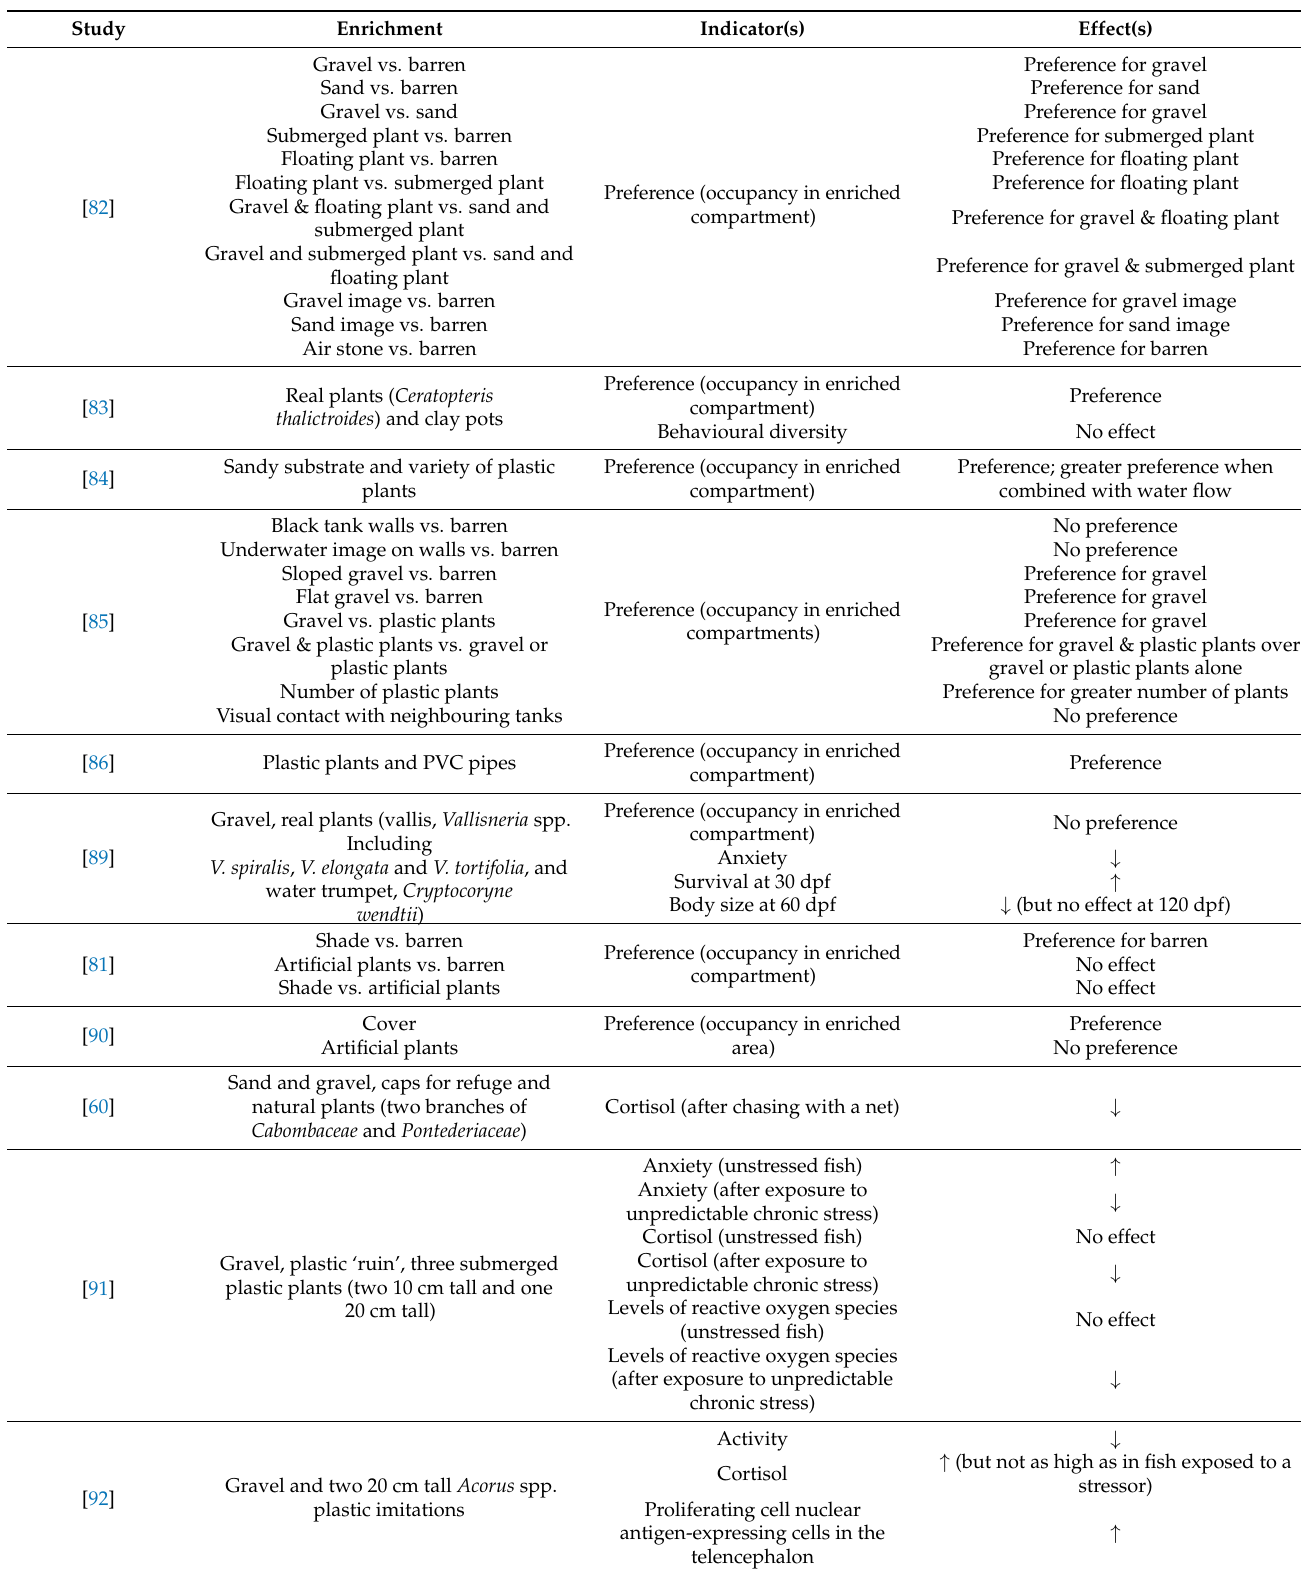
Table 2. Key results of studies relating to physical enrichment for laboratory zebrafish. Studies have been included where they have either addressed a preference (such as might be used to identify conditions which might promote welfare), or tested the effects of a condition intended to provide enrichment. Unless otherwise specified, all results here relate to the presence of the enrichment condition noted in the table compared with an absence of that